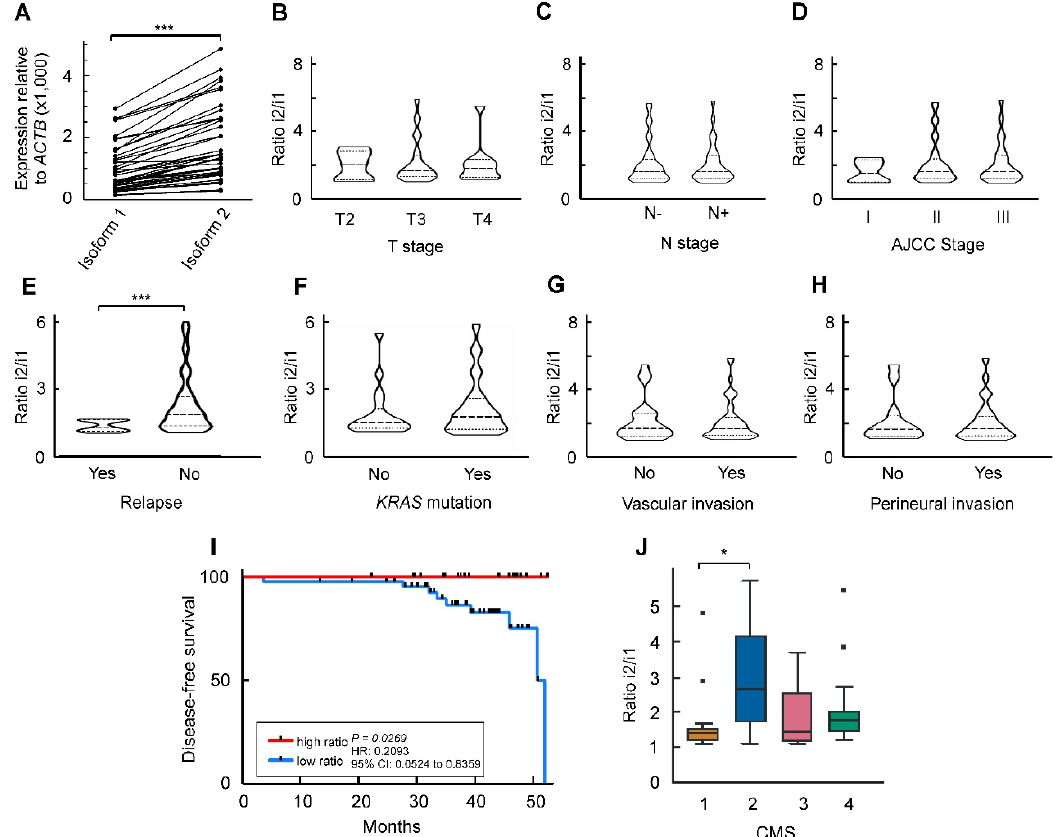
Figure 1. Expression of mRNA corresponding to the two main isoforms of ZNF518B to show that the isoform ratio correlates with the relapse of patients. ( A ) Differences in isoform level in tumour samples (a cohort of 66 patients was analysed). ( B – H ) Violin plots showing the changes in the ratio between isoform 2 and isoform 1 mRNA with respect to the clinicopathological properties of the patients’ cohort. In panels B and C, T and N stages are indicated in the conventional way. ( I ) Disease-free survival of patients as a function of the isoform 2/isoform 1 ratio. Patients were categorised in high- or low-ratio groups according to the median value of the ratio in the cohort. ( J ) Correlation of the ratio between isoform 2 and isoform 1 with the consensus molecular subtypes (CMS) classification. *, p < 0.05; ***, p < 0.001.